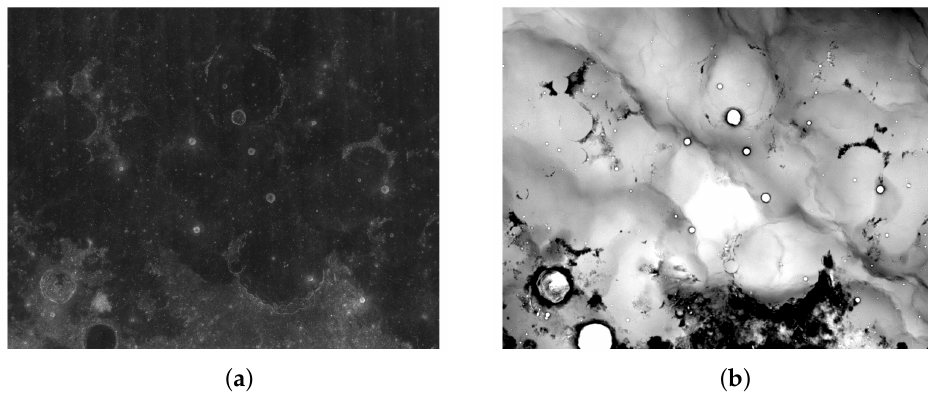
Figure 1. Examples of the two types of image of area 18 ◦ S ∼ 0 ◦ N 306 ◦ W ∼ 324 ◦ W: ( a ) digital orthophoto image (DOM) image; ( b ) digital elevation map (DEM)